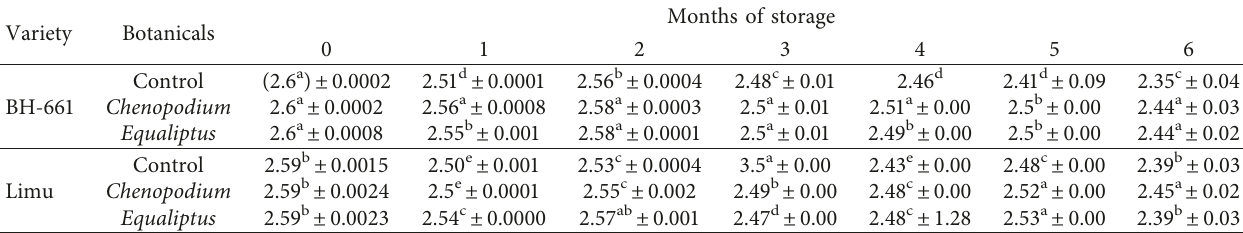
Table 1: Effect of botanicals and variety on log of thousand grain weight (mean ± SD) of maize. Variety